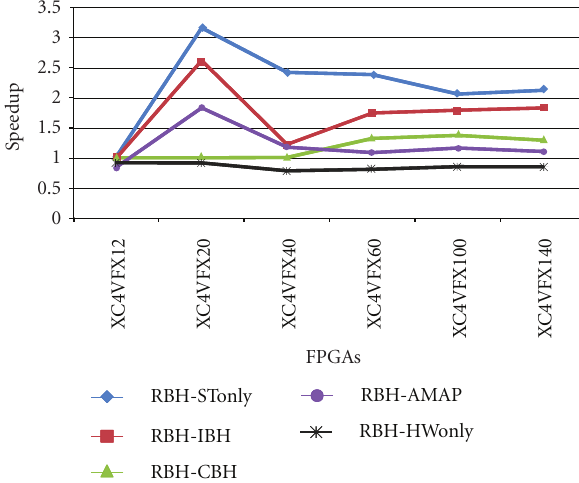
Figure 5: The performance increase of the RBH compared to HWonly, STonly, IBH, CBH, and AMAP. RBH performs better than AMAP under all resource conditions except XC4VFX12.